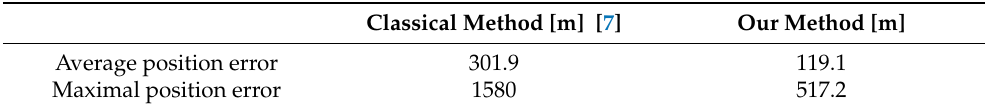
Table 1. Table with errors for one jammer in the field of view. Our method using neural network processing is compared with the classical method for TDOA.